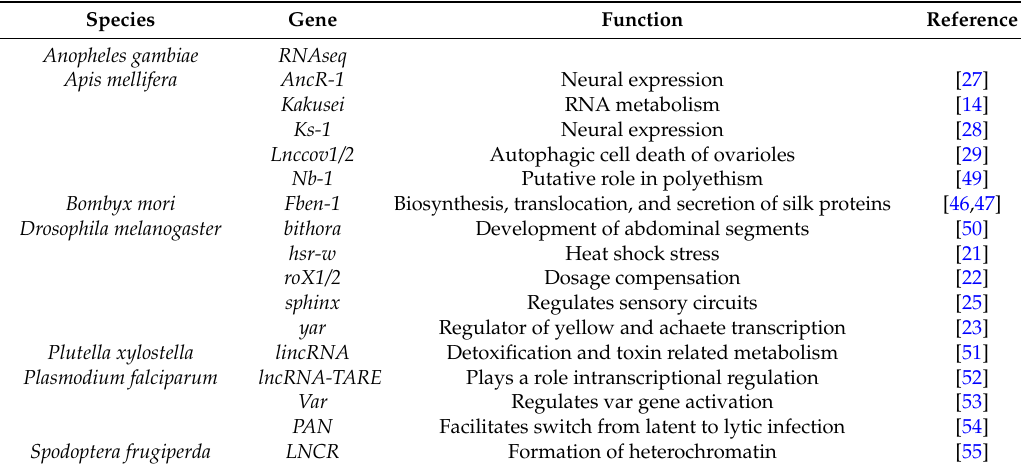
Table 1. lncRNAs reported in